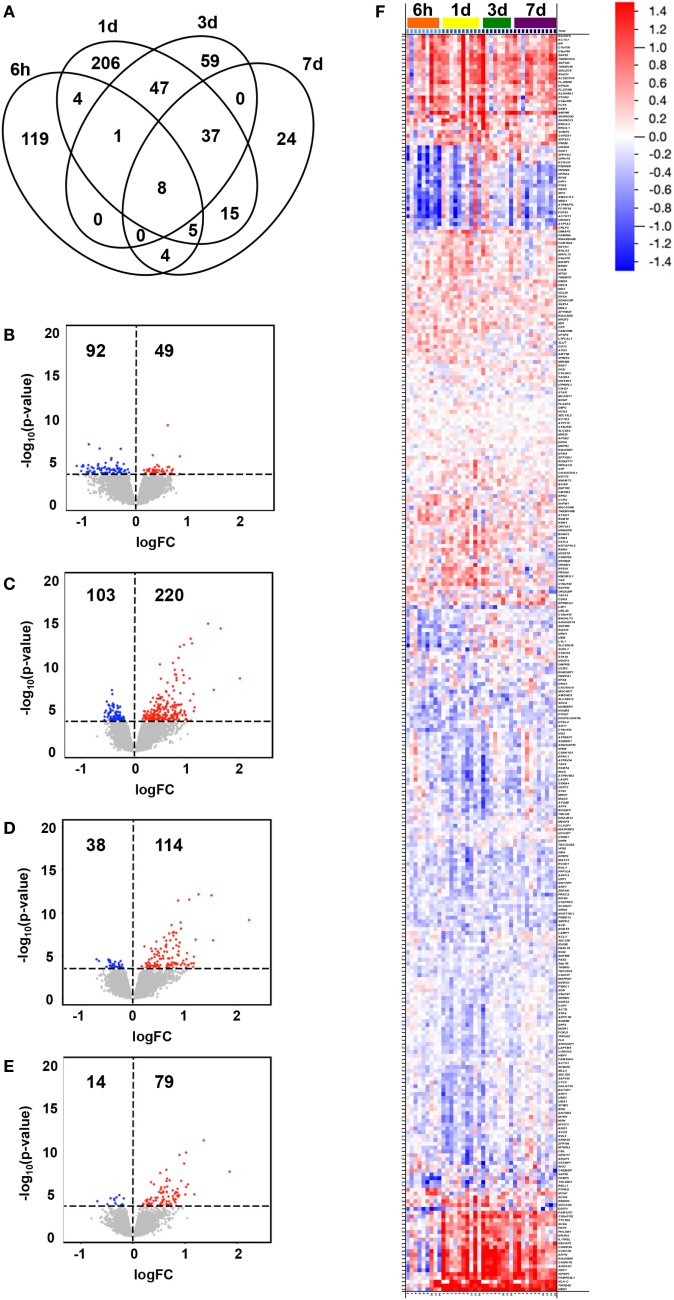
Transcriptional changes in gene expression over time following vaccination. Subjects were intramuscularly immunized with CN54gp140 + GLA. In the Venn diagram, (A) the number of unique and shared differentially expressed genes (DEGs) in whole blood at 6 h, 1 day, 3 days, and 7 days after immunization (compared to baseline, 0 h) are shown, while the numbers and magnitudes (y-axis) of upregulated (red dots) or downregulated (blue dots) DEGs at 6 h (B), 1 day (C), 3 days (D), and 7 days (E), are depicted in volcano plots. An overview of all DEGs hierarchically clustered and arranged by time, are shown in a heat map (F), according to the color legend (upregulated DEGs in red, downregulated in blue, log2FC scale).